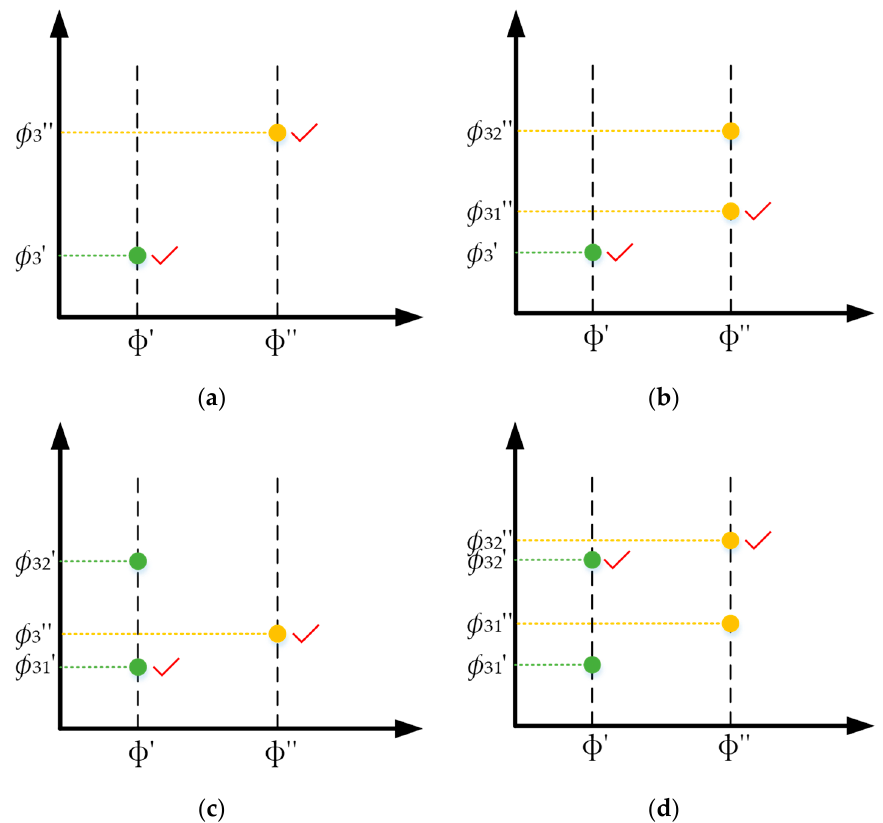
Figure 2. Distribution of all possible values of ф 3 : ( a ) There is one ф 3 value corresponding to each of the adjacent ф values; ( b ) The former ф value corresponds to one ф 3 value, and the latter ф value corresponds to two ф 3 values; ( c ) The former ф value corresponds to two ф 3 values, and the latter ф value corresponds to one ф 3 value; ( d ) There are two ф 3 values corresponding to each of the adjacent ф values.